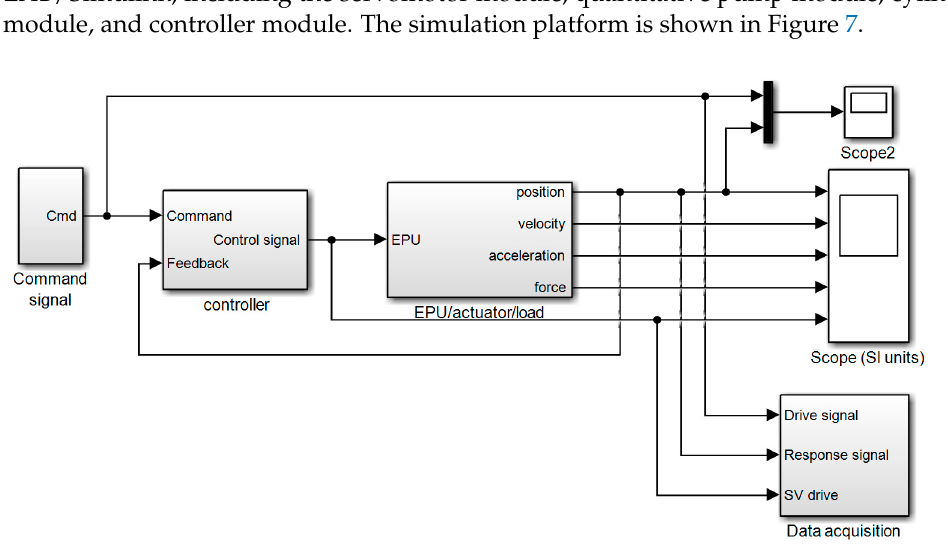
Figure 7. Simulation platform of the PCSM.